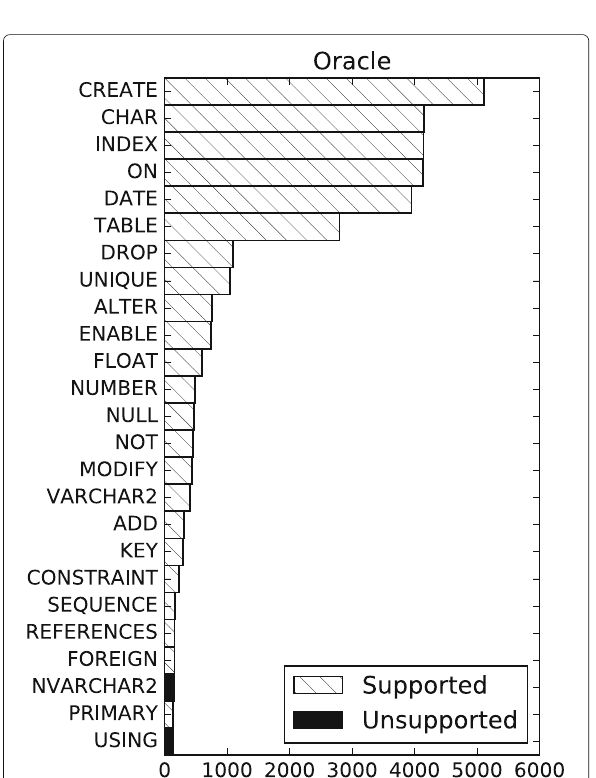
Fig. 6 Most frequent SQL keywords for